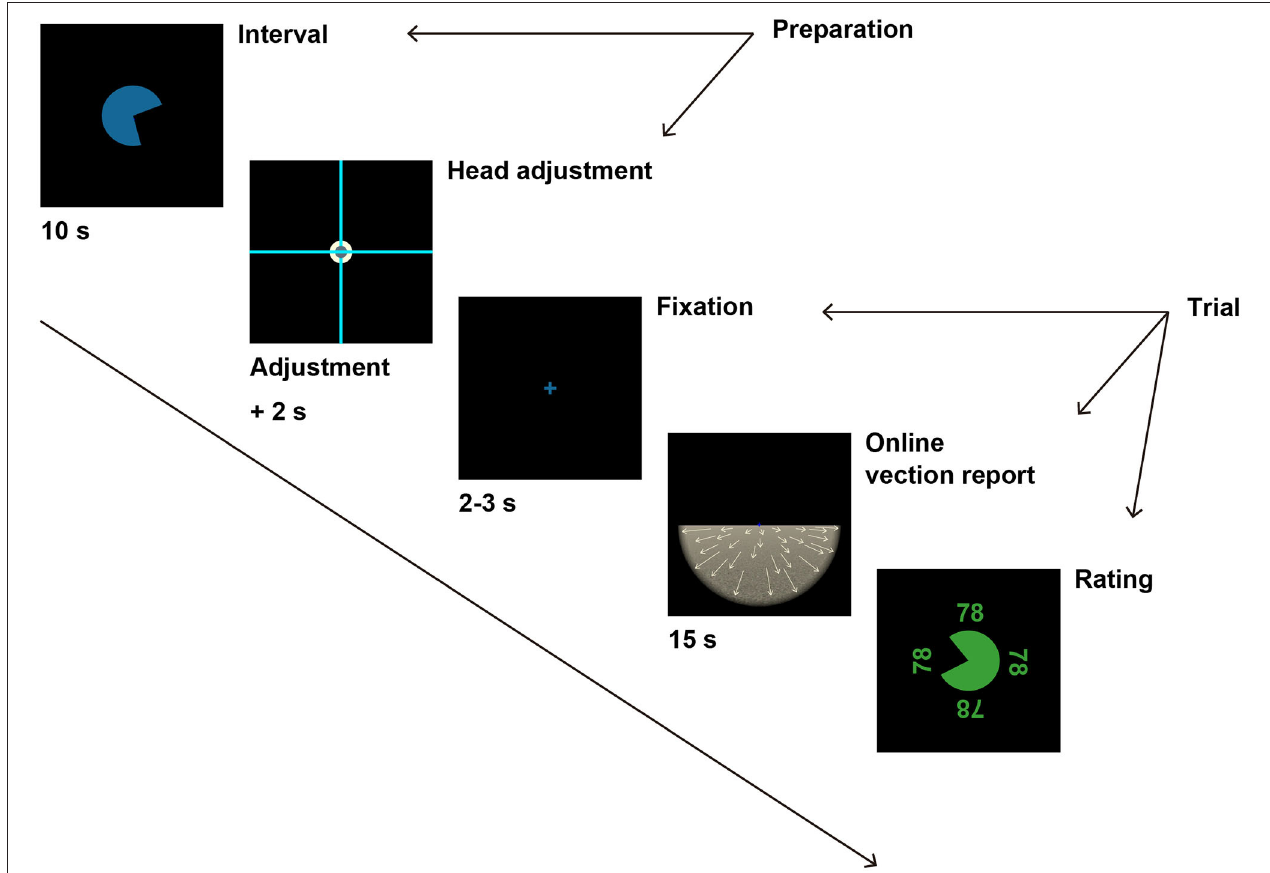
FIGURE 2 | A schematic illustration of the experimental procedure. After 10s of interval, participants were instructed to fit the head-fixed cross to the scene-fixed cross to prepare for the next trial. If participants were able to fit the two crosses for 2s, the adjustment crosses disappeared, and a fixation cross appeared instead. The fixation cross was followed by optic flow stimulus after a random duration between 2 and 3s. Participants reported vection experience by pressing a button during the optic flow presentation. After the optic flow presentation for 15s, participants evaluated the overall magnitude of vection strength by moving the round gauge. See Procedure in Methods for